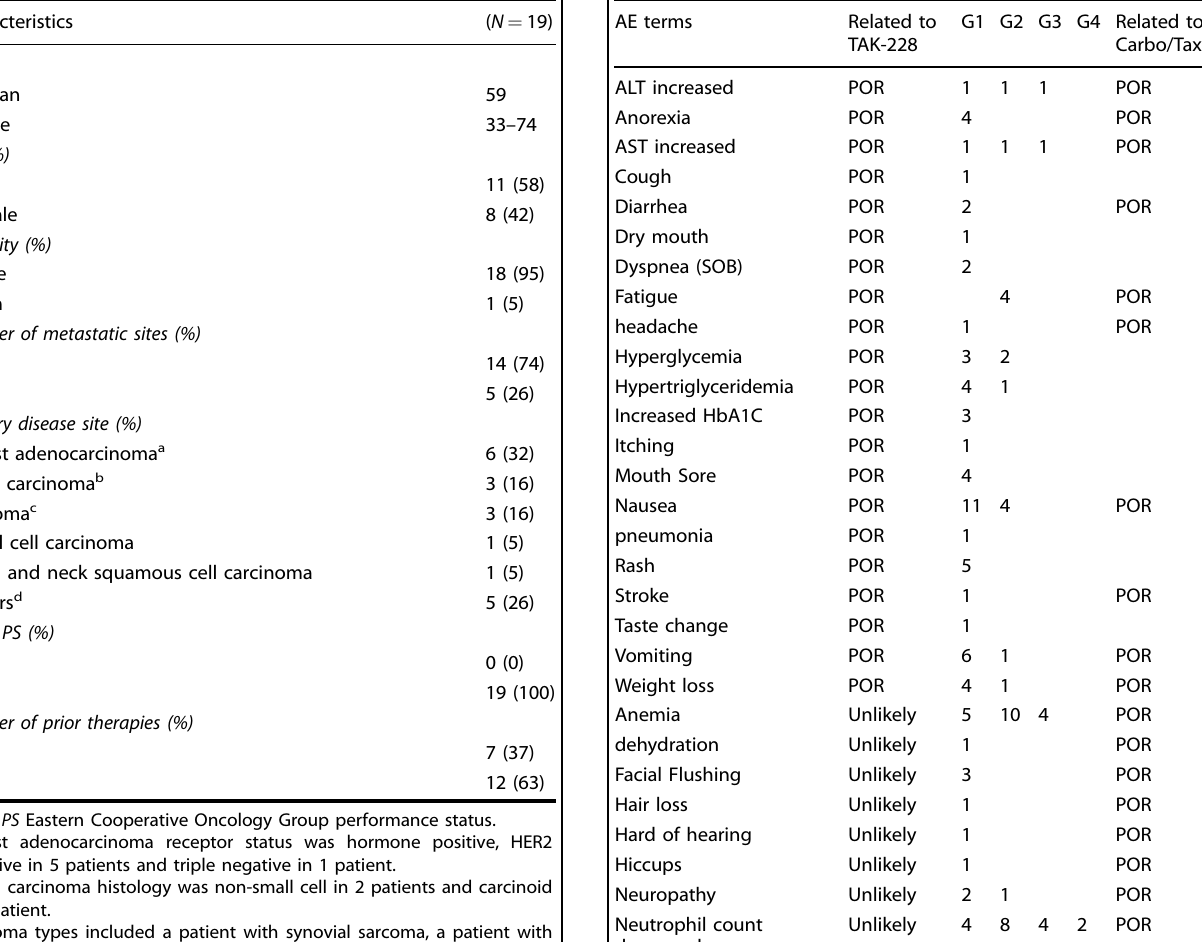
Table 1. Patient baseline characteristics and demographics. Table 2. Treatment-related adverse